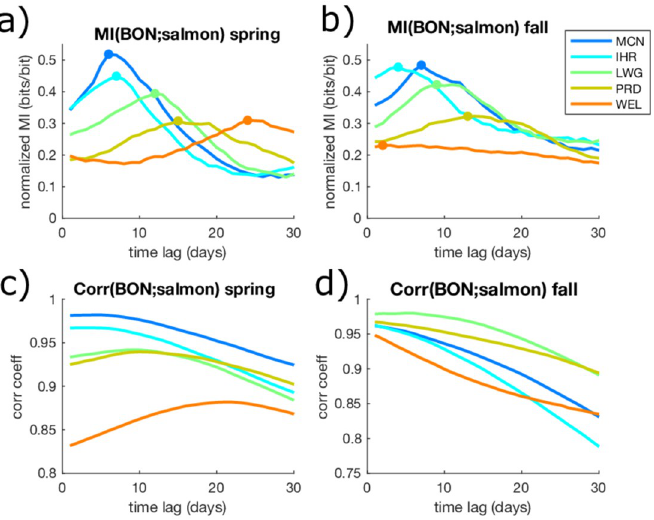
Fig 4. Mutual information (MI) (a,b) and linear correlation (Corr) (c,d) between BON daily salmon counts and counts at upstream dams for spring run (a,c) and fall run (b,d) salmon, for time lags, τ , from 0 to 30 days. Dots indicate lag times associated with peak MI , which are used as τ in TE computations for conditioning on knowledge BON of lagged salmon counts at BON.